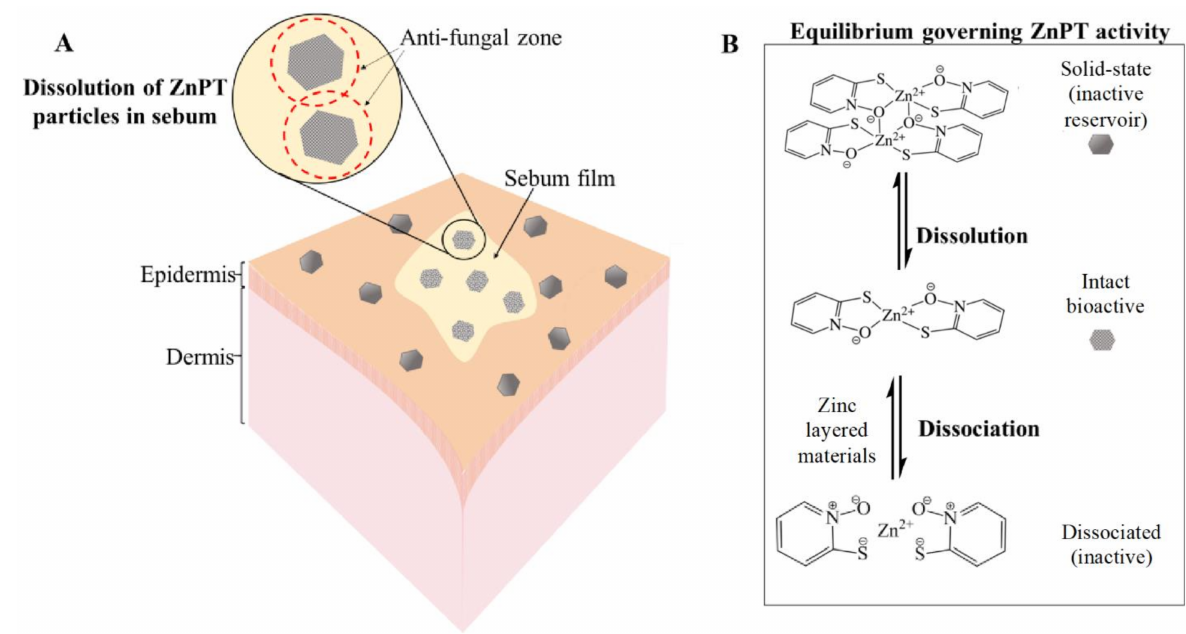
Figure 5. Zinc pyrithione deposition on the skin. ( A ) Solid-state ZnPT particle dissolution occurring in a film of sebum covering the skin surface releasing bioactive ZnPT. ( B ) Equilibria governing anti-fungal delivery to the follicles with zinc layered materials boosting levels of bioactive species.